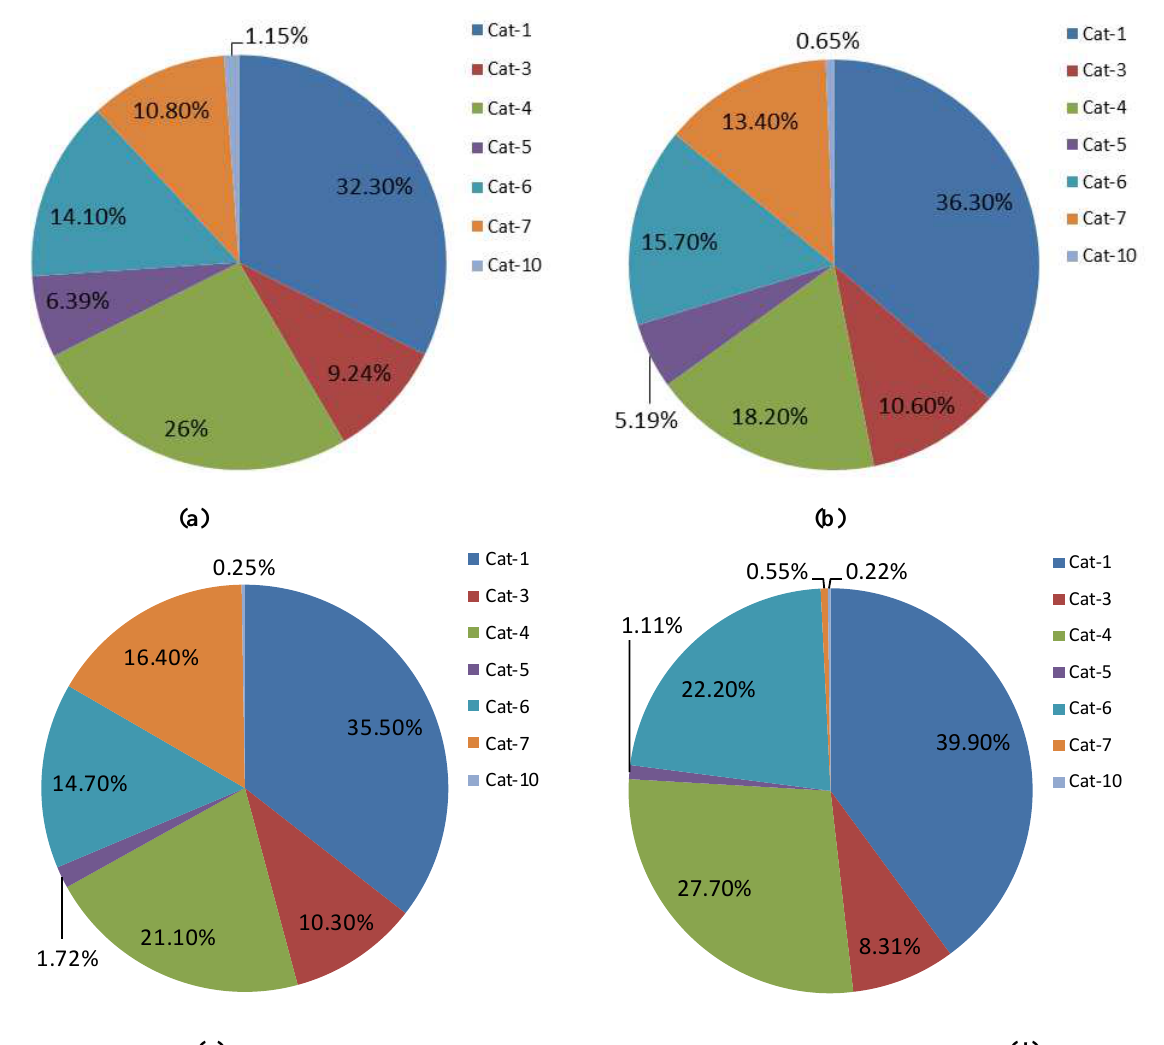
Figure 2. Important categories of healthcare waste components at different level healthcare facilities in